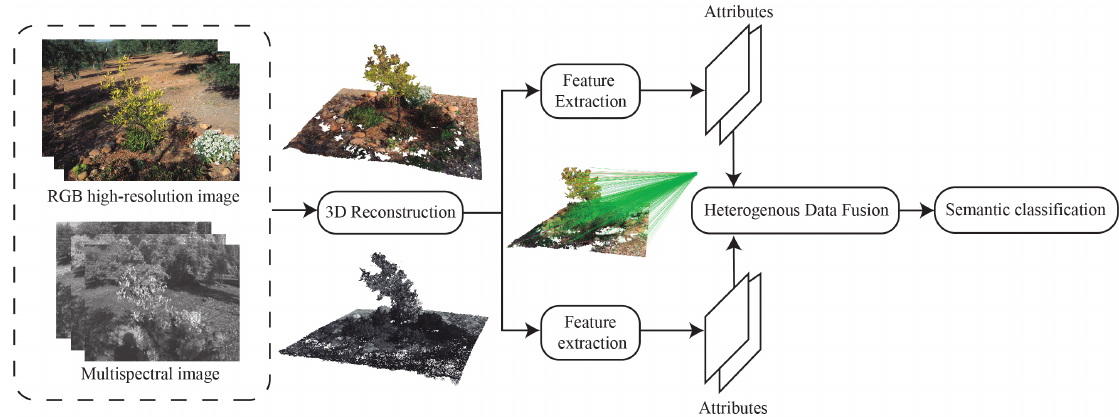
Figure 1. The flow diagram of the proposed